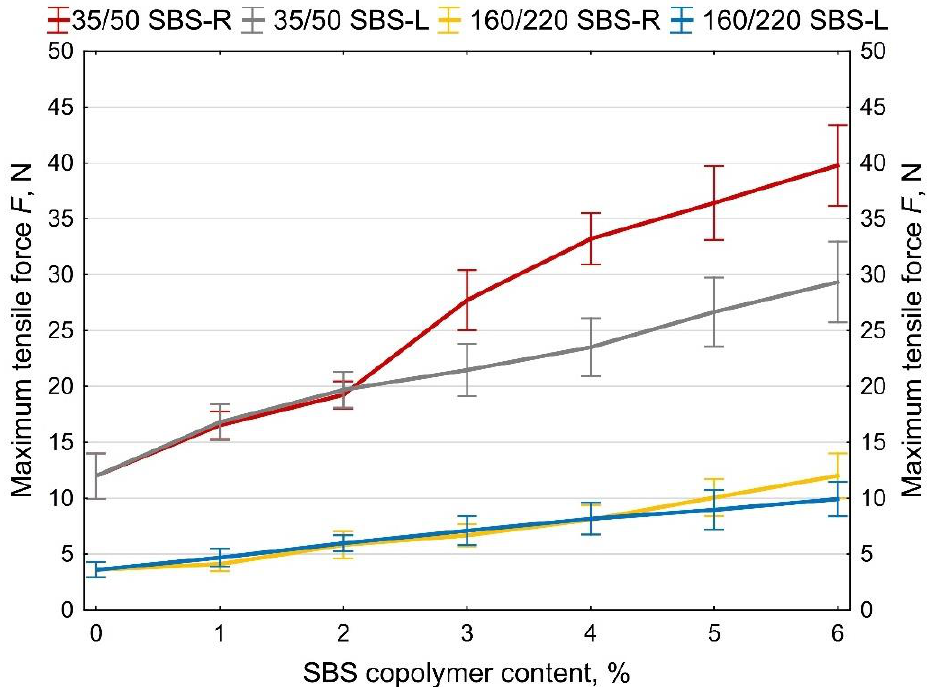
Figure 14. The maximum tensile force of SBS-modified asphalt binders determined using the force ductility test, error bars show a 95% confidence interval for the mean.